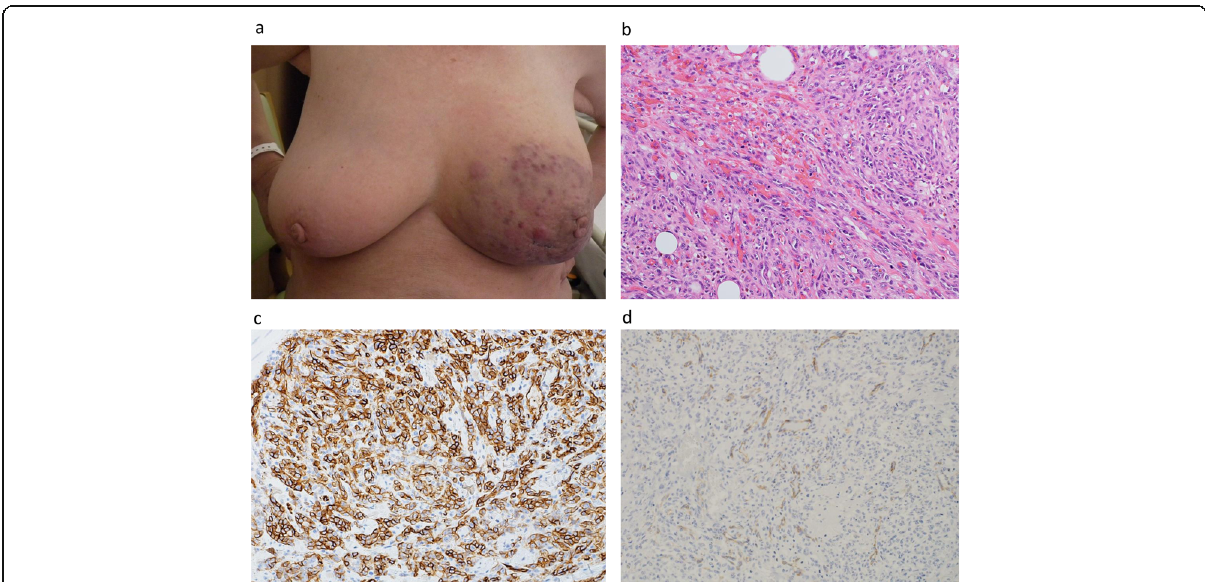
Fig. 3 a T he skin nodules and color changes on the inferior side of the left breast 3 years after right breast conserving therapy. b Microscopic